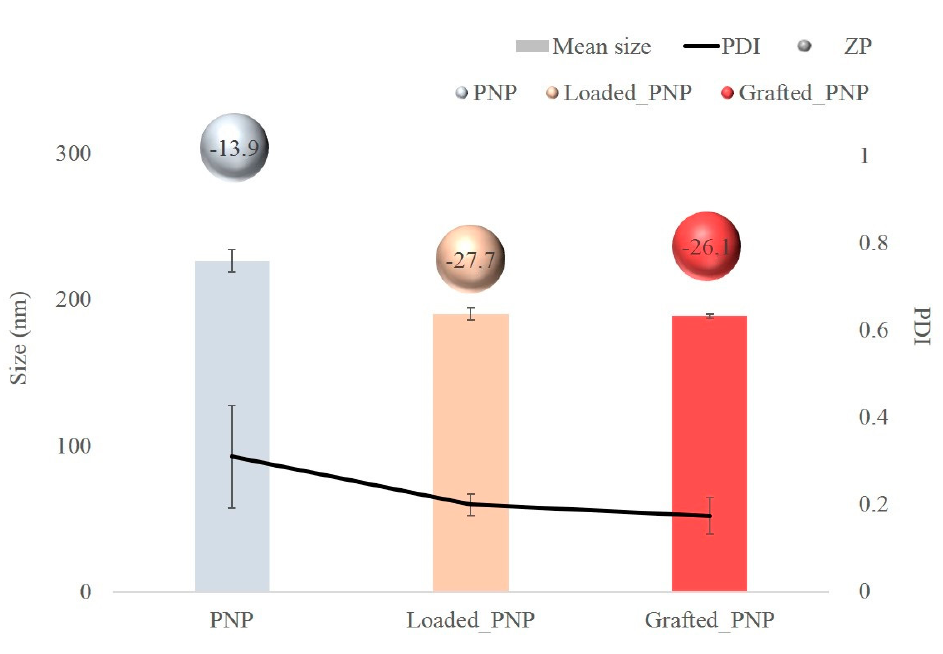
Figure 5. Comparative values in term of mean size (nm), PDI and ZP values (mV) of bare PNP; loaded-PNPs and grafted-PNPs.